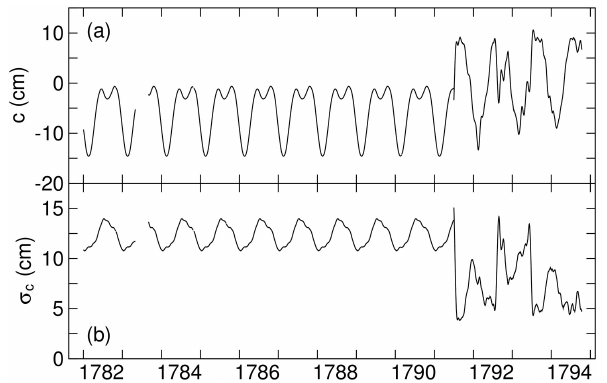
Figure B1. Thirty-day filtered corrections (a) and errors (b) . Discontinuities on 1 July 1791 appear because the data prior to and from that date onwards were filtered